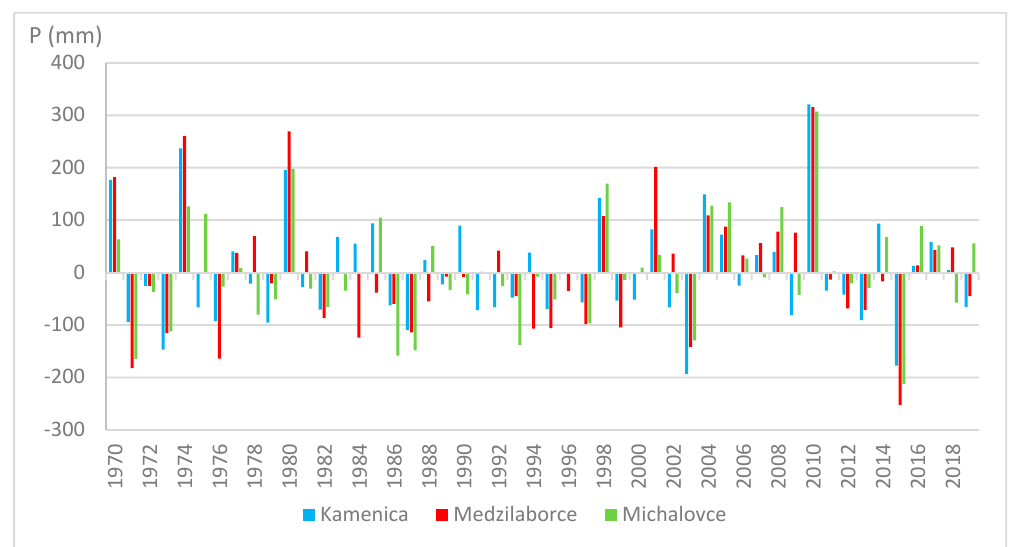
Figure 2. Anomalies of the annual precipitation (P) totals relative to the average value from the multi-year period 1970–2019 at selected meteorological stations.